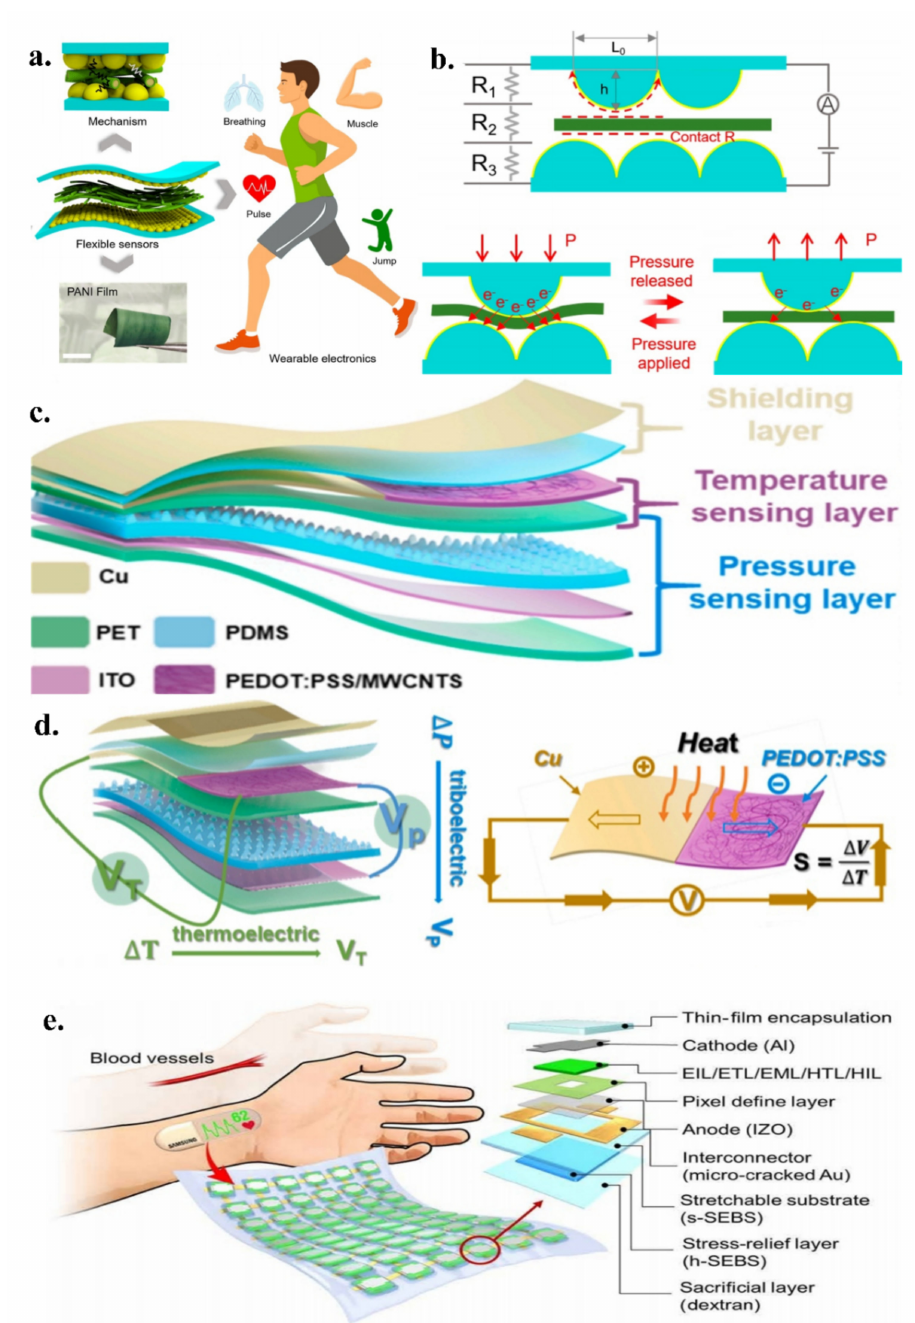
Figure 3. ( a ) Patch − type piezoresistive sensor; reproduced with permission from the American Chemical Society (2021) [96]; ( b ) Electrical signal output from the sensor; reproduced with permission from the American Chemical Society (2021) [96]; ( c ) Electronic skin that senses pressure and tempera- ture independently; reproduced with permission from Elsevier (2022) [98]; ( d ) Temperature signal from the electronic skin; reproduced with permission from Elsevier (2022) [98]; ( e ) A self-contained skin − like health care patch; reproduced from Ref.